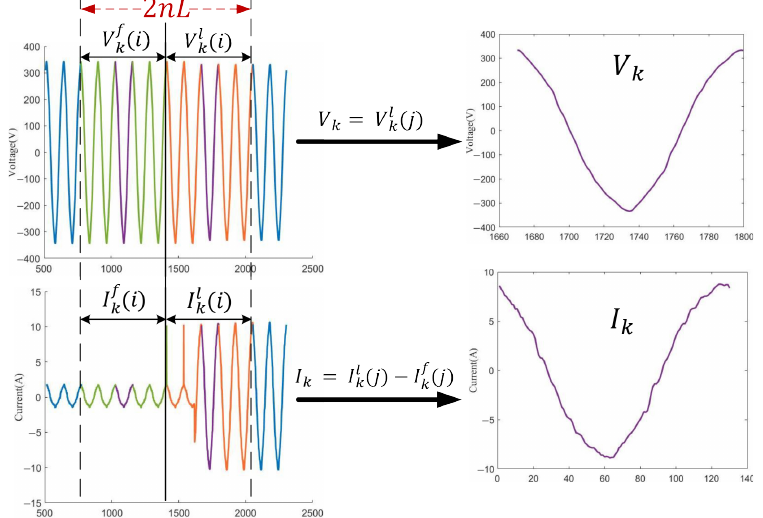
Figure 3. Load electrical signal data preprocessing